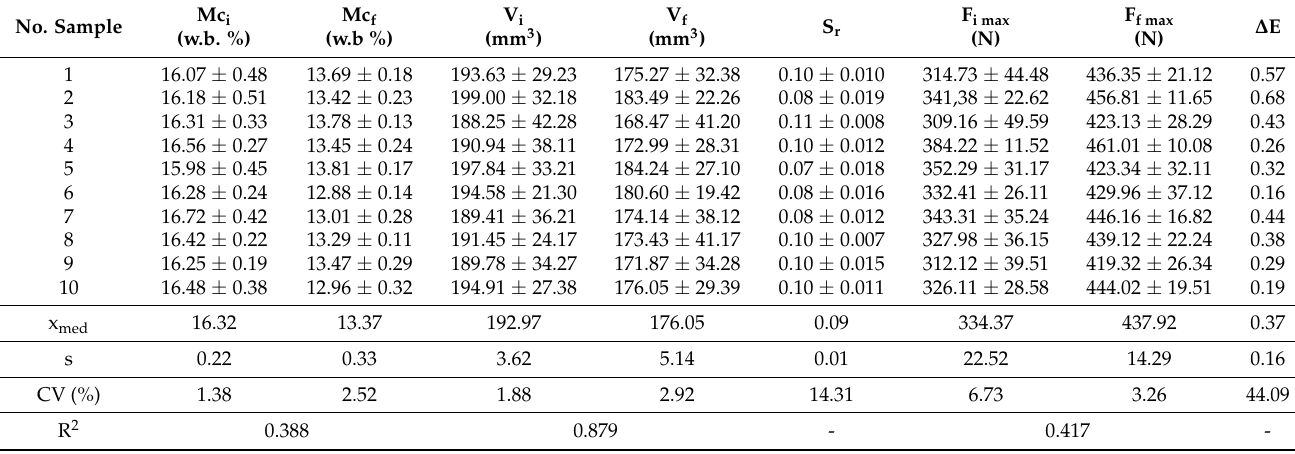
Table 1. Physical changes in corn seeds subjected to